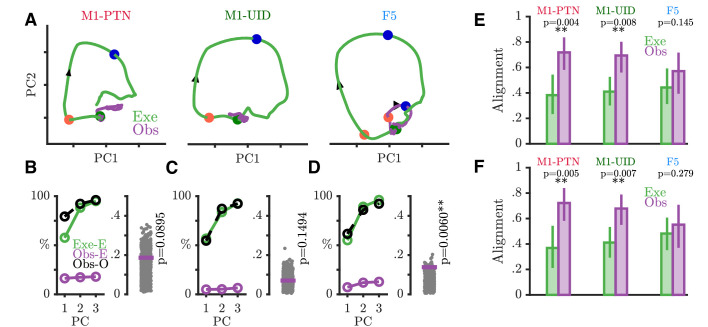
Execution and observation activity within a movement subspace.(A) Traces showing the evolution of M1-PTN, M1-UID and F5 population activity within a 2-D movement subspace (defined by movement execution activity) across PG execution (green) and observation (purple) trial conditions. Larger coloured circles on each trajectory mark key events (green - Go, orange - HPR, blue - DO) used for multiple alignment of neural activity, and arrows on trajectories indicate direction of time. (B) M1-PTNs Left Panel: Cumulative variance captured by the first three principal axes. Exe-E (green), execution variance in execution subspace; Obs-E (purple), observation variance in execution subspace; Obs-O (black dashed line), observation variance in observation subspace. Exe-E and Obs-E projections correspond to those shown in (A), Obs-O projection corresponds to the denominator of alignment measure. Right Panel: Alignment index of observation activity in the movement subspace (purple horizontal line). Execution alignment index is equal to one by definition (not shown). Scattered grey points show alignment values from the null distribution, and p-values denote proportion of alignment values in null distribution greater than true alignment (C) Same as B., but for M1-UIDs. (D) Same as B, but for F5. (E) Bootstrap distributions of alignment values for WHG projected onto PG-defined axes, for execution and observation in each sub-population. P-values denote proportion of execution alignment values greater than observation values. (F) Same as (E), but for PG projected onto WHG axes.